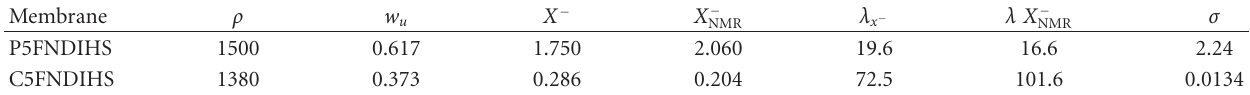
Table 1: Density in Kgm − 3 , ρ , water uptake in Kg H 2 O/Kg dry membrane, w u , IEC in equivalents of fixed anionic groups per Kg